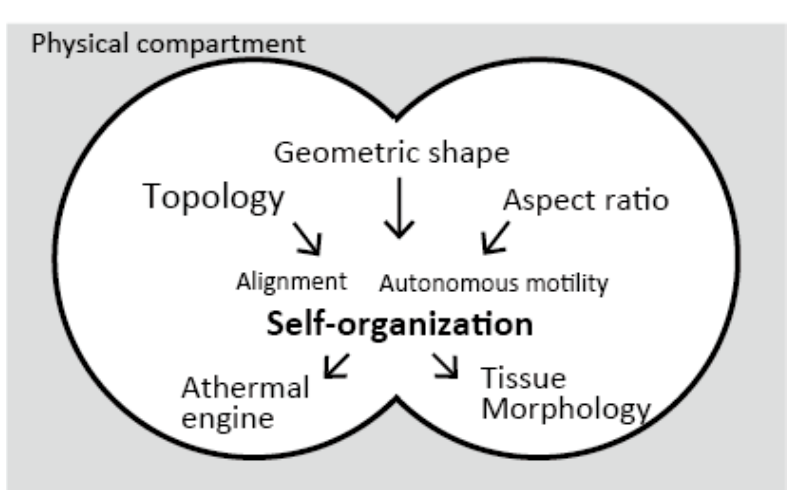
Figure 5. The effect of the geometric boundary for bioreactors and active matter. ( A ) Cell-sized confinement defined as biological compartment can be involved in biological function through geometry-induced TX-TL regulation. ( B ) The designed geometry of physical compartment is responsible for the control of self-organization of the group of active matter. The effect of geometric shape, its aspect ratio, and topology are essential to control self-organized patterns. The precise control of such pattern formation may be relevant to tissue morphogenesis or athermal engine.